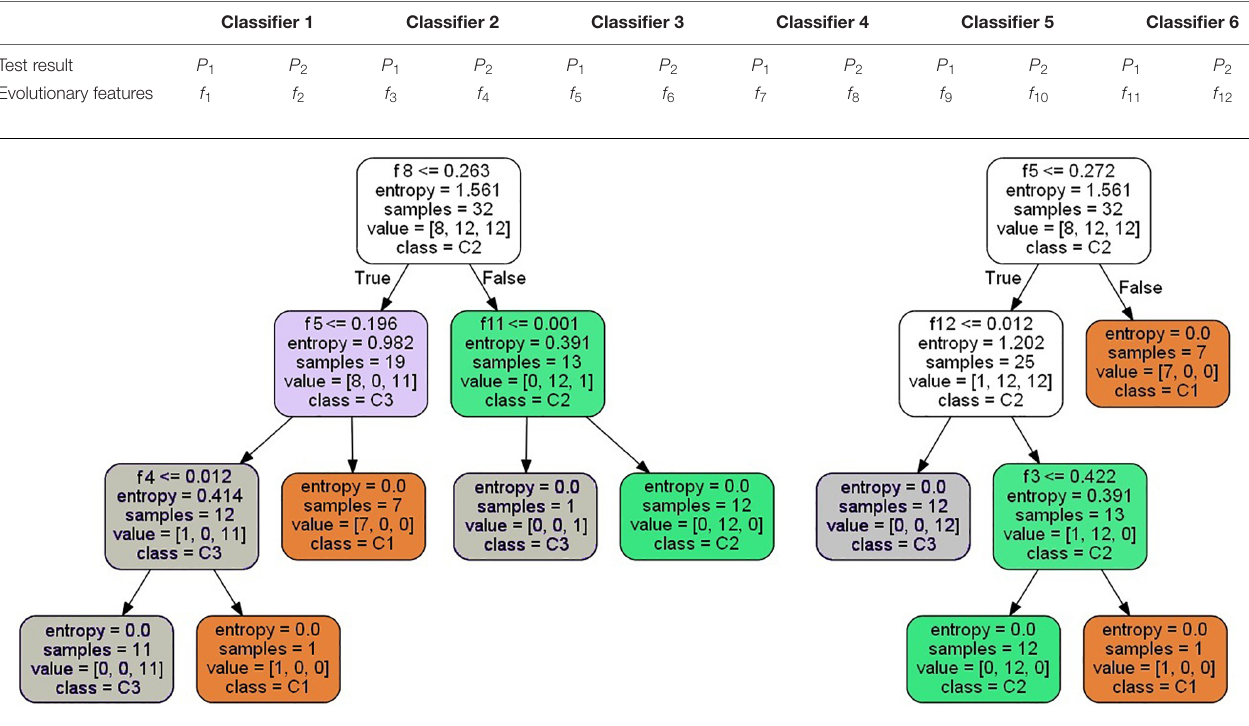
FIGURE 6 | Two decision trees constructed by randomly choosing the samples and the